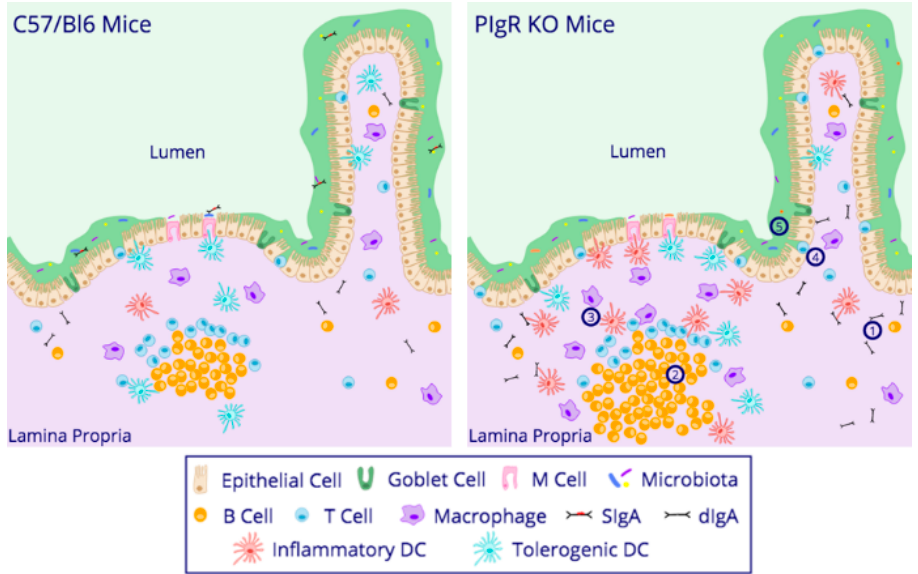
Figure 2. Small intestinal alterations in pIgR knock-out (KO) mice compared to C57/Bl6 control mice. PIgR KO mice exhibit enhancements in: (1) serum IgA, (2) B cells, (3) macrophages and dendritic cells, and (4) intraepithelial lymphocytes. PIgR KO mice also exhibit (5) alterations in bacterial communities.